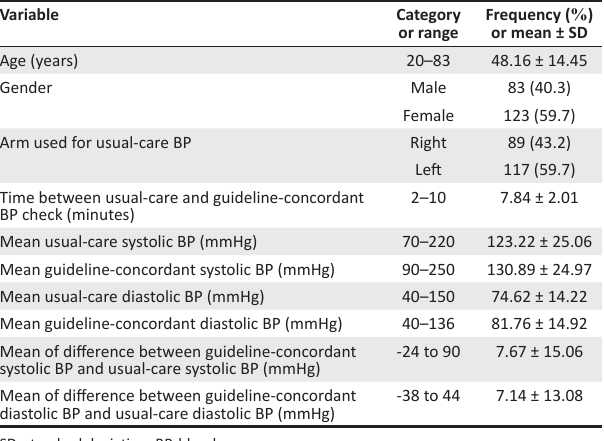
TABLE 1: Baseline demographic and clinical